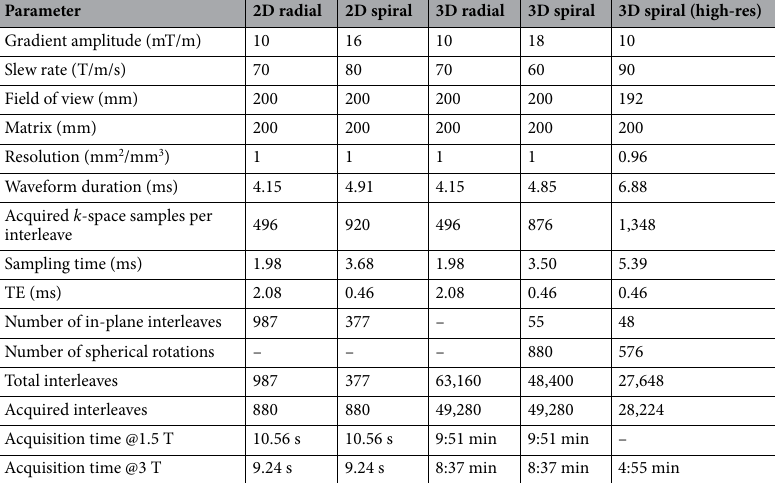
Table 1. Readout trajectories and experimental details.